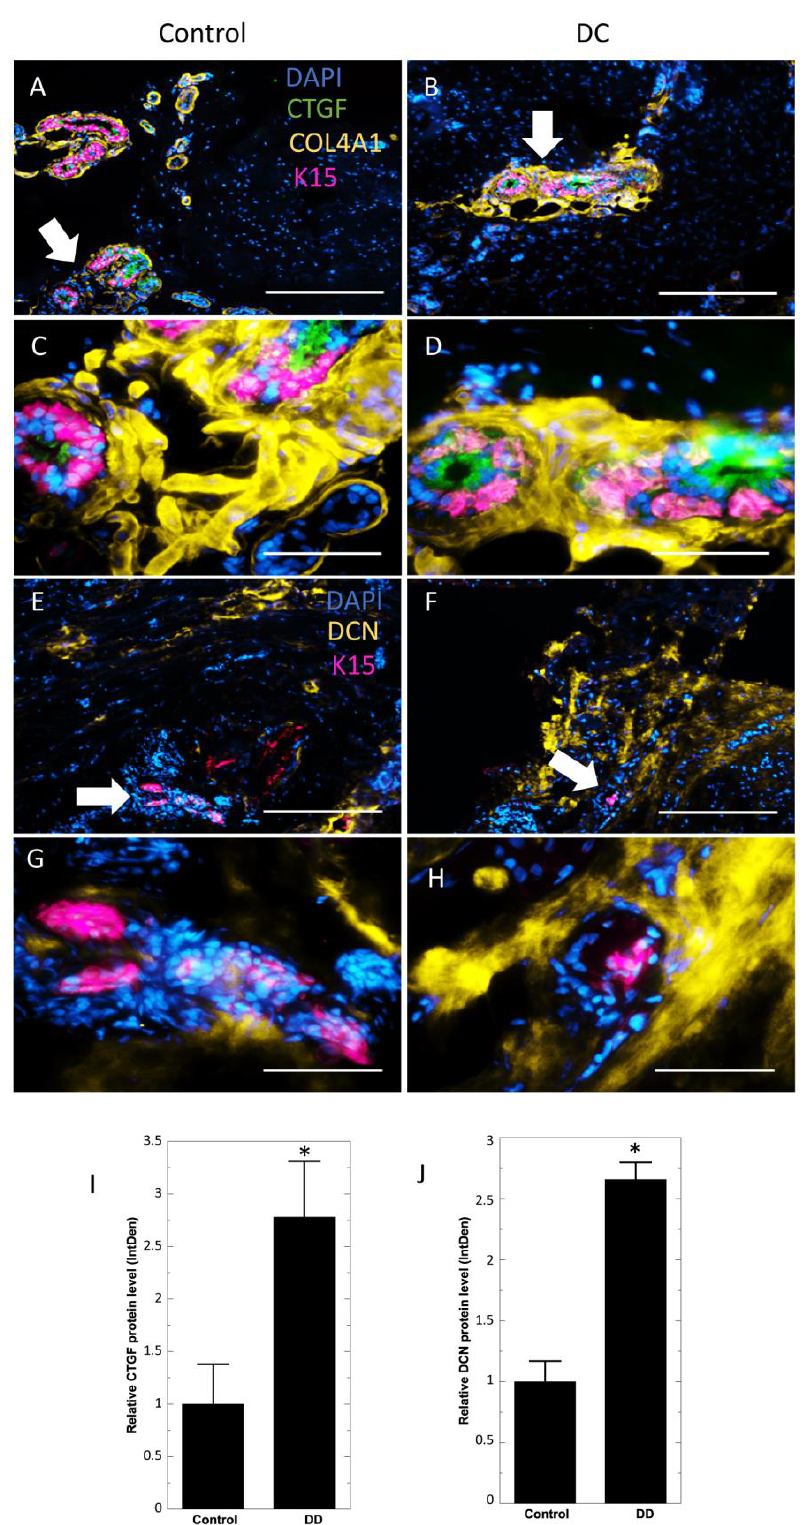
Figure 2. Sweat glands of Dupuytren’s contracture samples present high levels of CTGF and decorin. Immunofluorescence analysis of control and DC samples were stained for keratin 15, CTGF, and Collagen IV ( A – D ), and for keratin 15 and decorin ( E – H ). Scale bar: ( A , B , E , F )—200 µ m; ( C , D , G , H )—50 µ m. Arrows in ( A , B , E , F ) show the area amplified in ( C , D , G , H ), respectively. Quantitative analysis of CTGF ( I ) and decorin ( J ) levels in control and DC samples. Results are presented as mean ± SD and compared to control samples. * p <